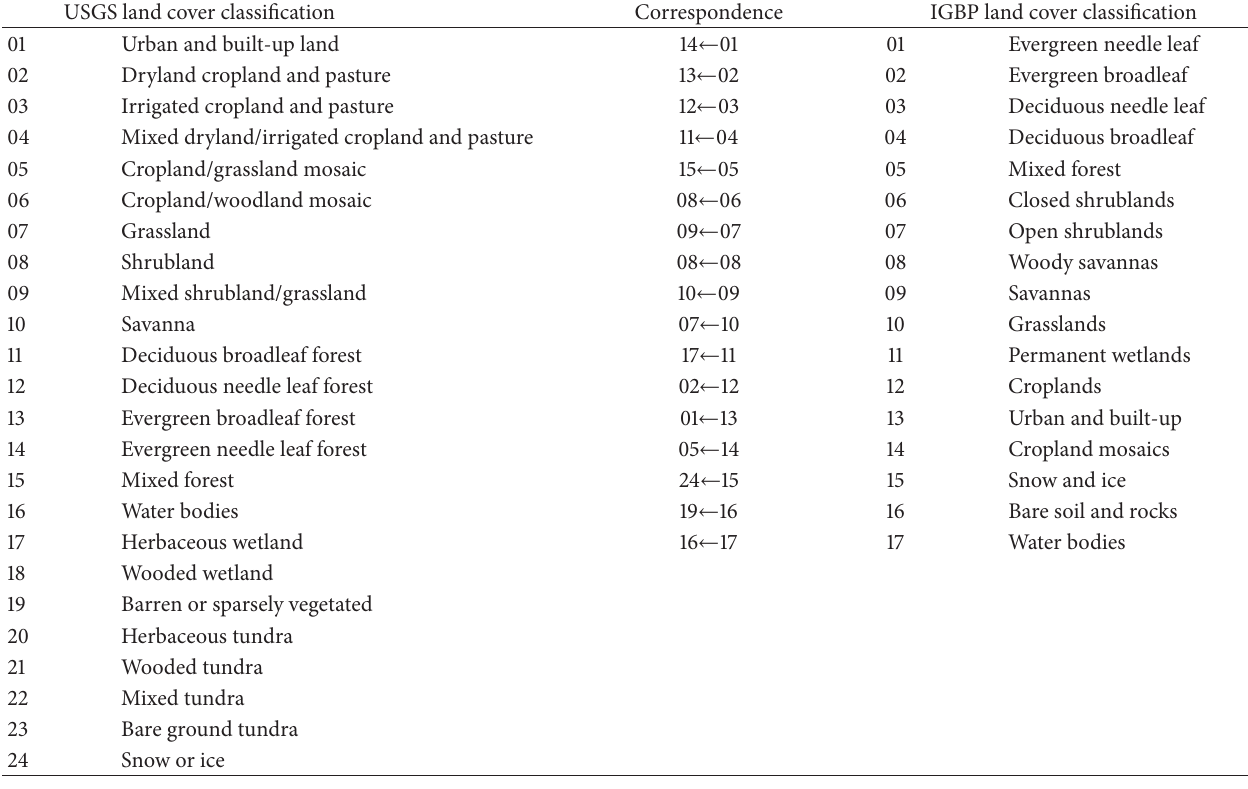
Table 3: Remapping tables of land-cover and land-use classification.